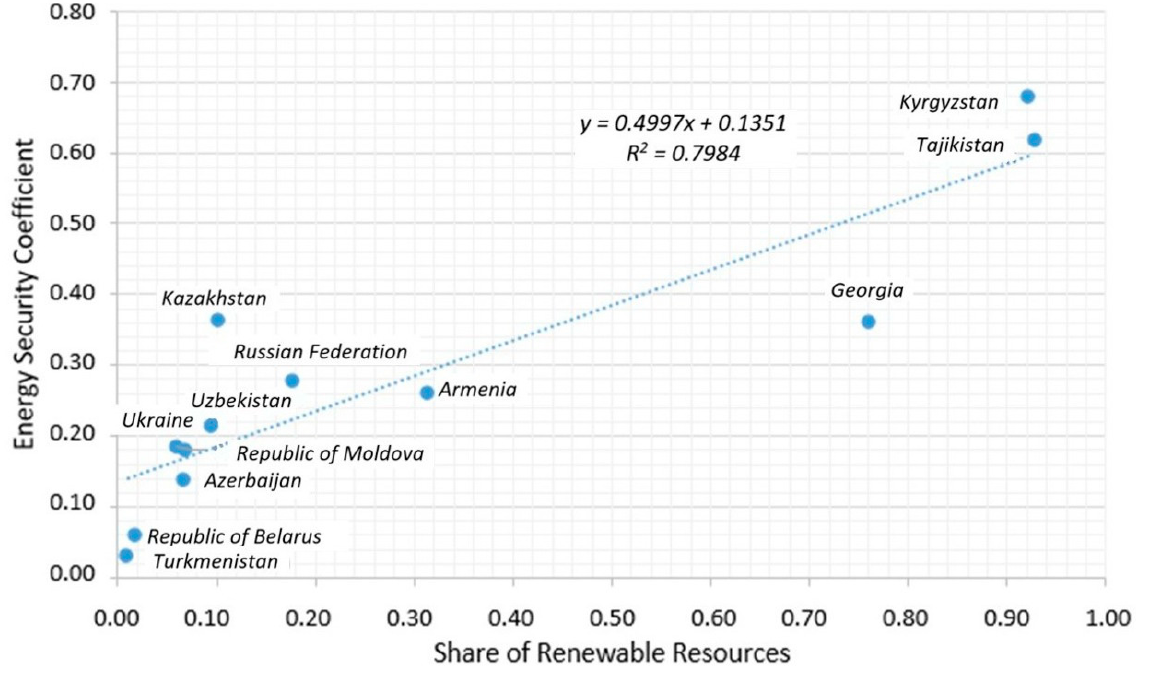
Figure 4. Actual interdependence of share of RES and energy security in EECCA countries in 2019. Source: compiled by the authors.